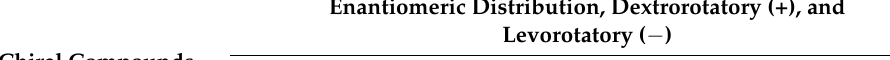
Table 11. Enantiomeric distributions of chiral terpenoids present in commercial wintergreen from Nepal and China; “–” indicates not detected; “+” indicates